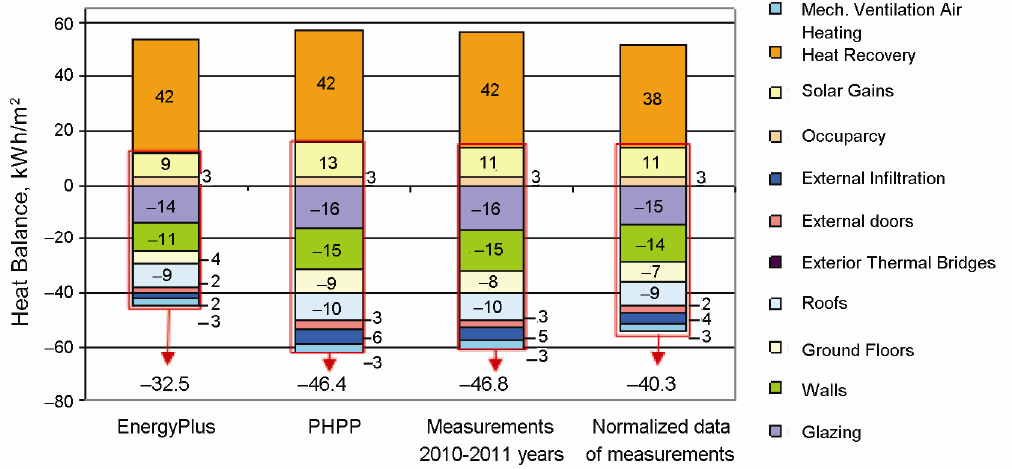
Fig. 5. Annual heat balance of the low energy